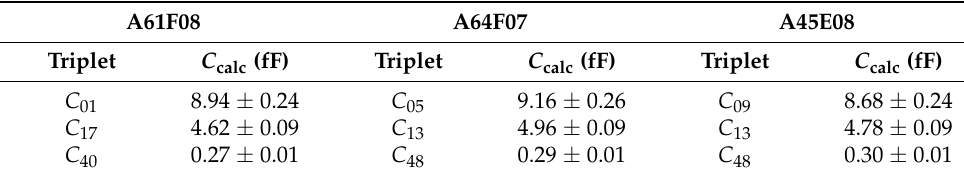
Table 2. Calculated capacitances of reference triplets and combined standard uncertainties. The triplets were selected from patterns labelled A61F08, A64F07, and A45E08.